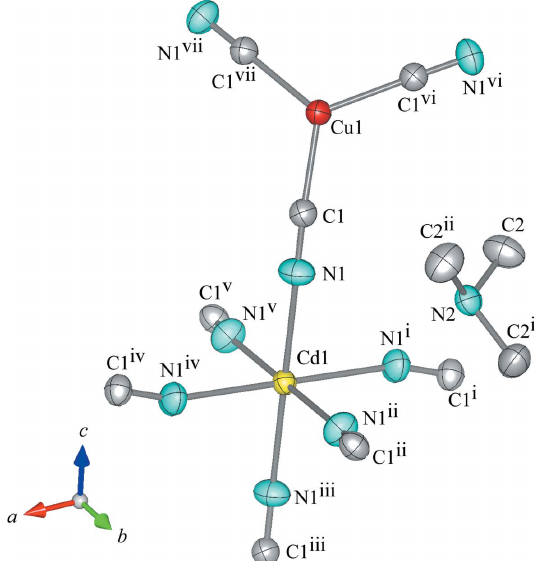
, (cid:2) y + 1 , (cid:2) z ; (xi) 2 2